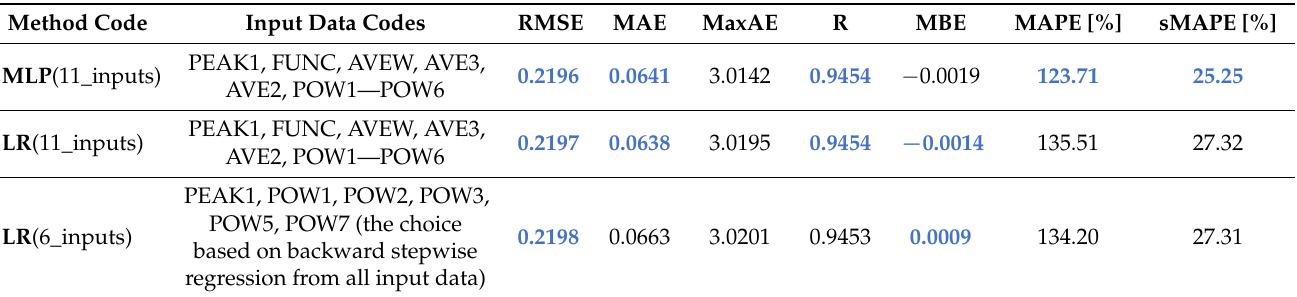
Table 6. Performance measures of proposed single methods (on test subset) for time series No. 1. Method